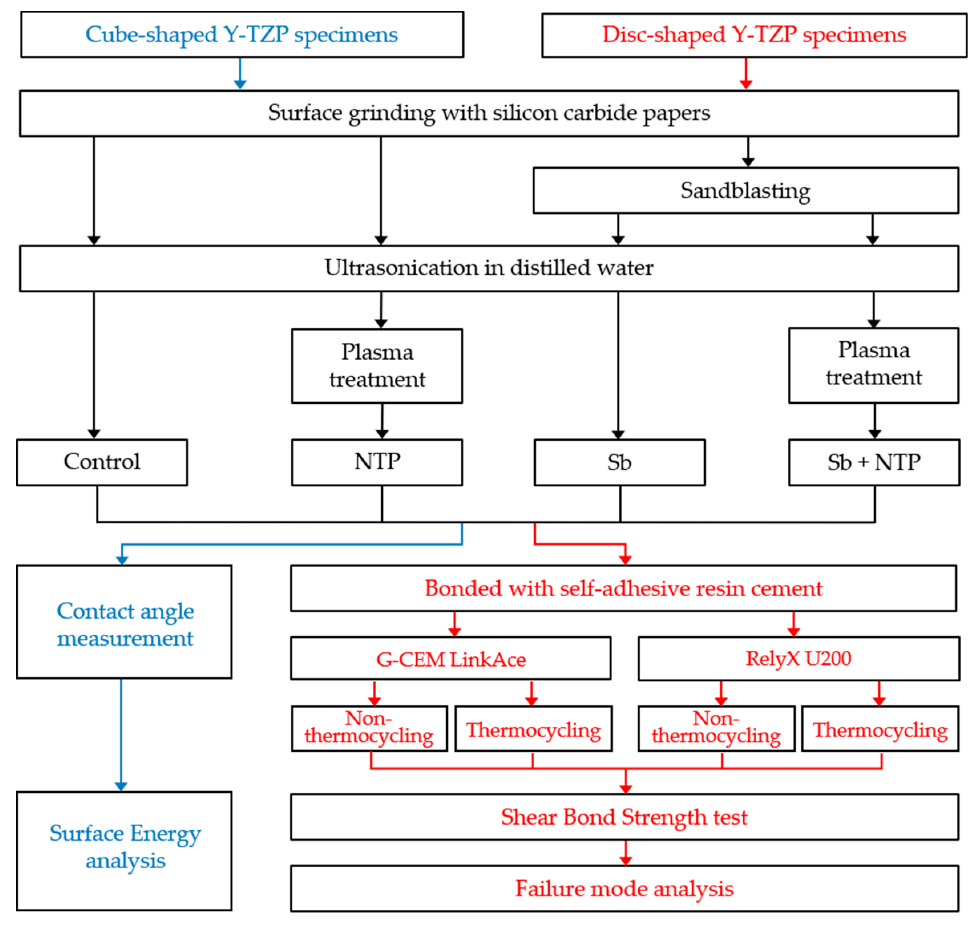
Figure 1. Flowchart of the experimental process. Table 1. Distribution of yttria-stabilized tetragonal zirconia polycrystal (Y-TZP) specimens for the